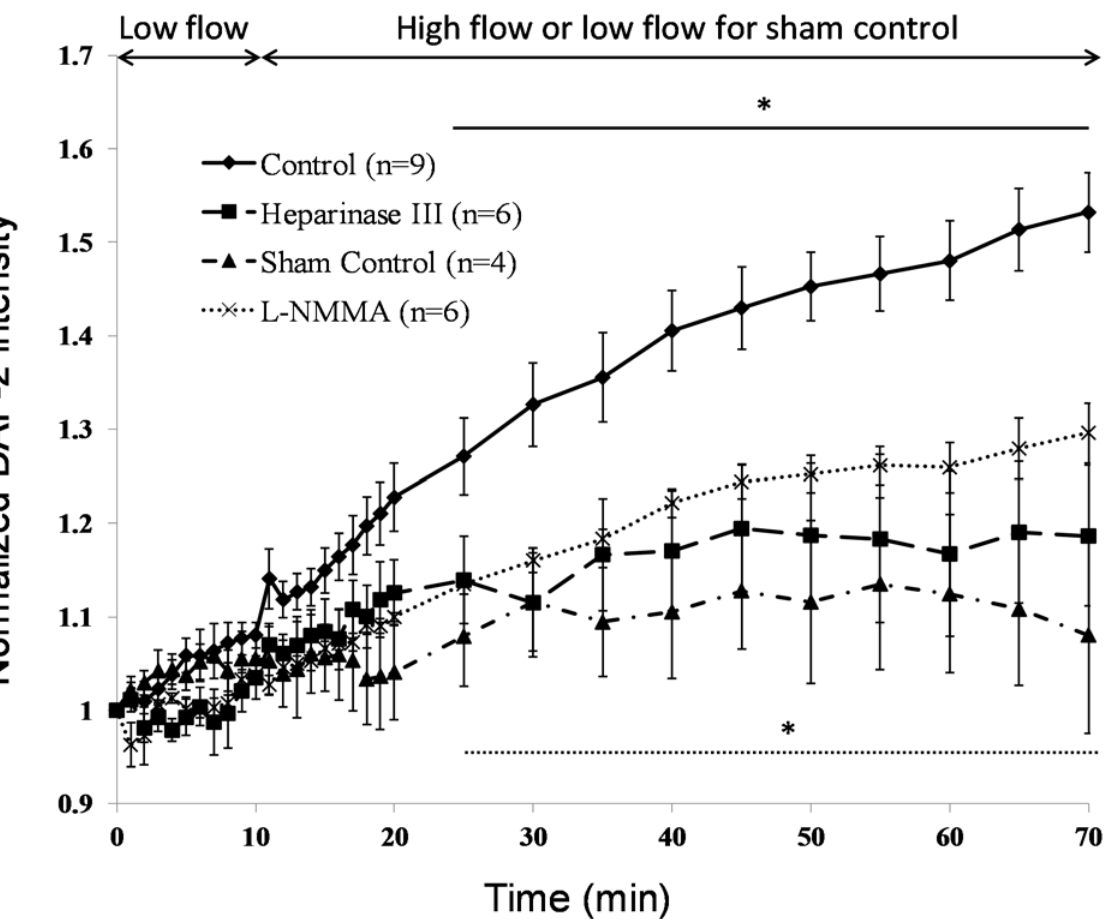
Figure 3. Flow-induced increases in NO production (DAF-2 intensity normalized by that after 45min DAF-2 DA loading) under various conditions in post-capillary venules. The solid line with diamonds is for the control perfusing 1% BSA-Ringer under the low flow (~300 μ m /s) for 10 min and the high flow (~1000 μ m/s) for 60 min; the dash-dot-dash line with triangles is for the sham control perfusing 1% BSA-Ringer under the low flow for 70 min; the dashed line with squares is for that with 1 h pretreatment of heparinase III; and the dotted line with crosses is for that in the presence of L-NMMA. * p < 0.05 compared with that at 10 min low flow (for the control and L-NMMA treatment).